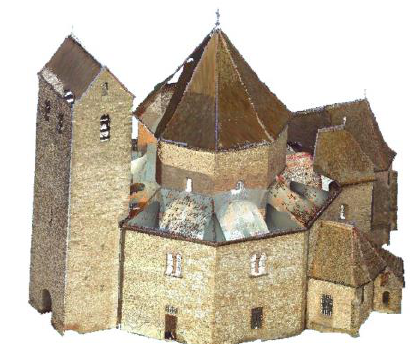
Figure 3. Colorized point cloud of Ottmarsheim’s abbey-church